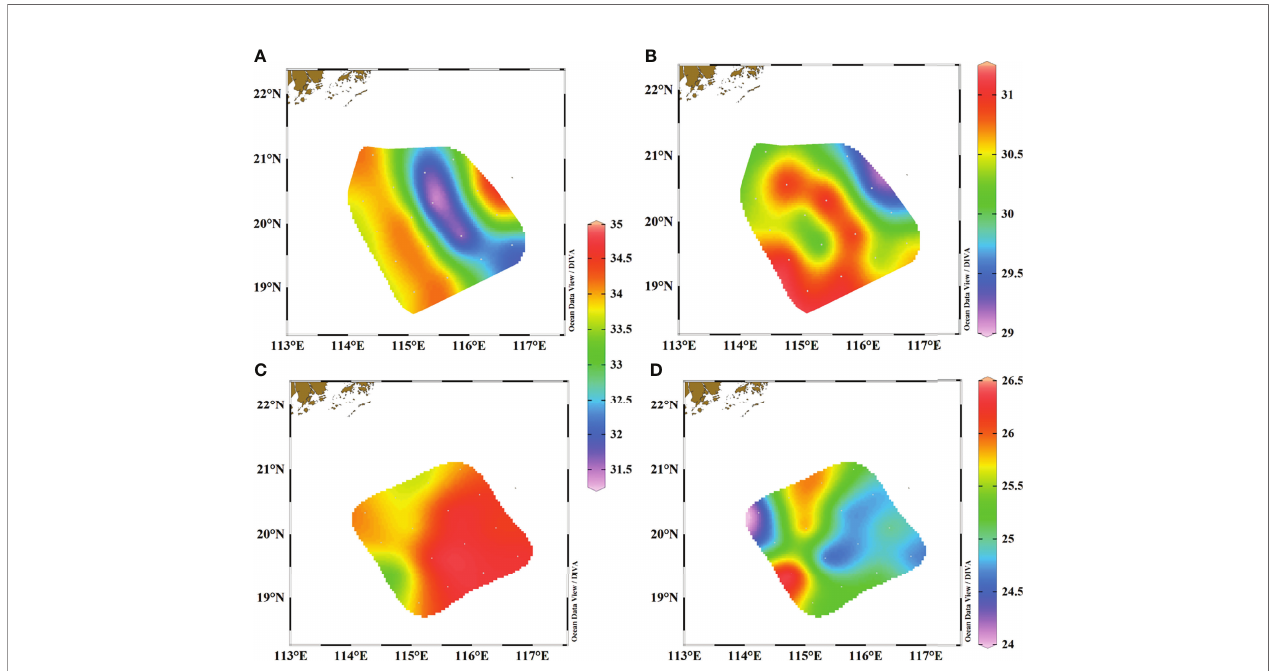
FIGURE 2 | Distributions of surface salinity and temperature in our study area. (A) salinity in June 2015, (B) temperature in June 2015, (C) salinity in March 2017, and (D) temperature in March